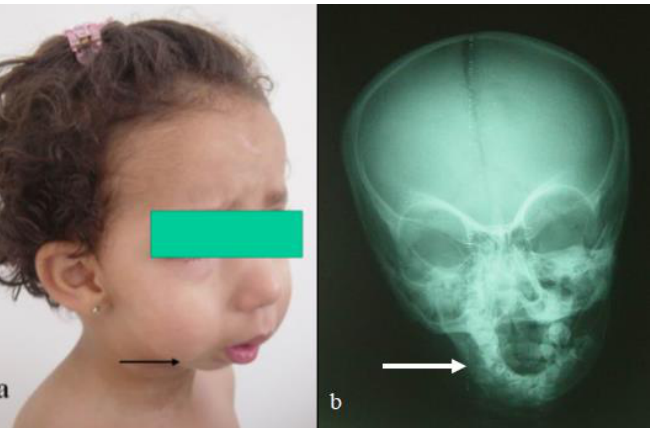
Figure 9. Clinical photo of a 4-year-old- girl with progressive hemi-atrophy of the right side of the face, which shows apparent unilateral facial atrophy of the right side of the face (arrow) ( a ); AP skull radiograph showed apparent atrophy of the right side of the mandible, giving rise to unilateral micrognathia (right sided atrophy of the maxilla, and the alveolar process of the maxilla) (arrow) ( b ).